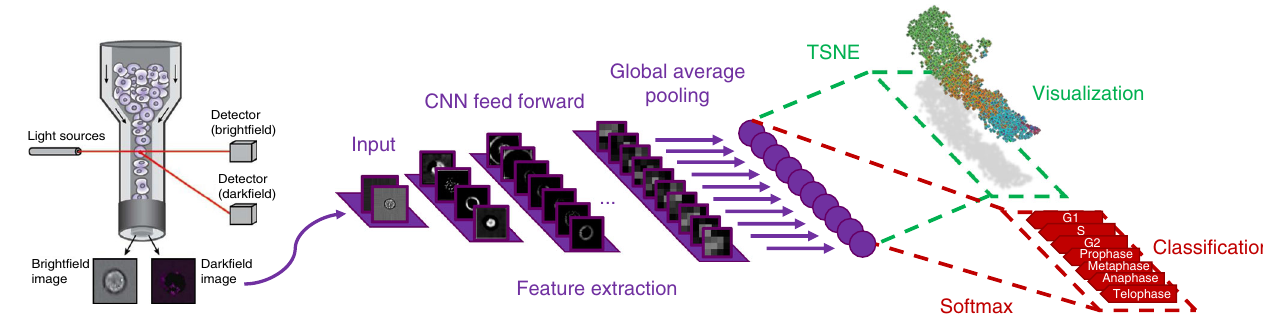
Fig. 1 Overview of analysis work fl ow. Images from all channels of a high-throughput microscope are uniformly resized and directly fed into the neural network, which is trained using categorical labels. The learned features are used for both classi fi cation and visualization